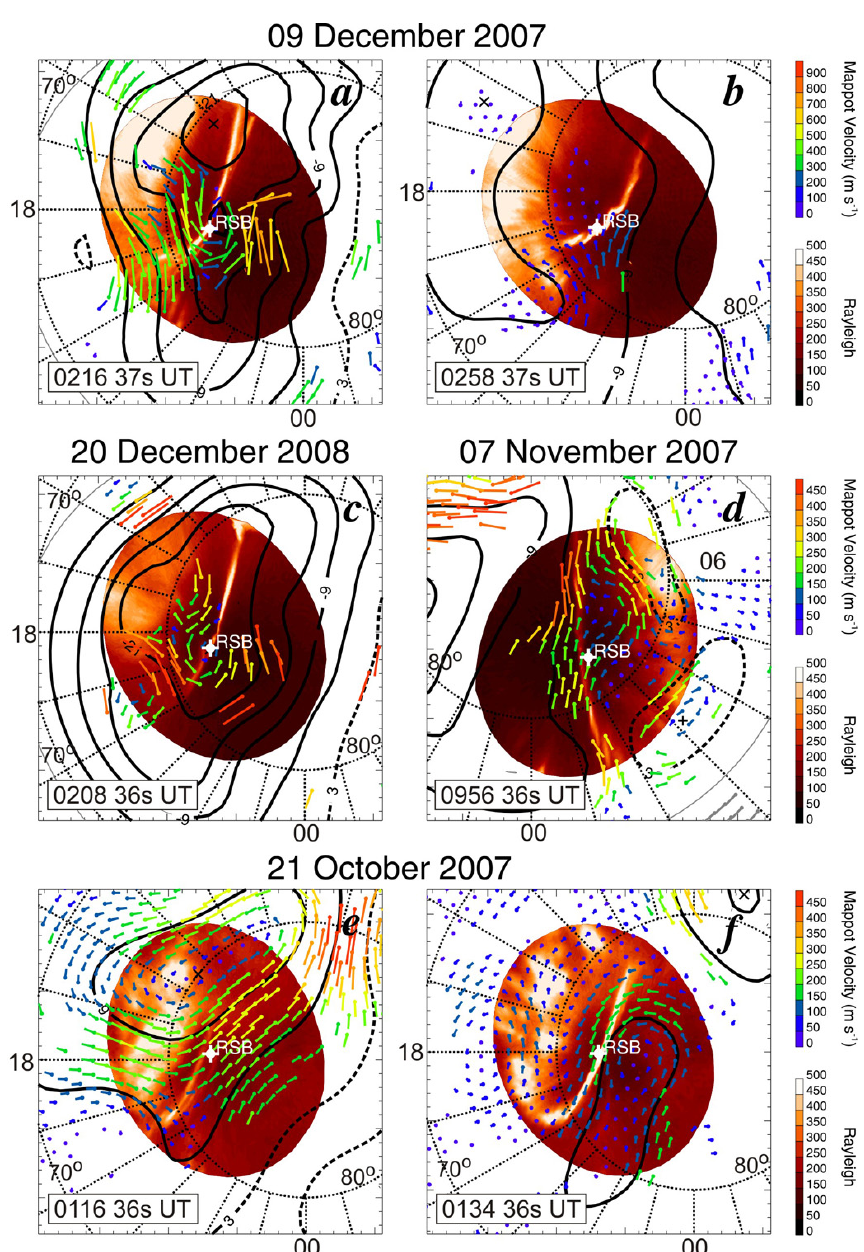
Fig. 11. SuperDARN convection maps with overlaid auroral images for selected scans on (a) , (b) 9 December 2007, (c) 20 December 2010, (d) 7 November 2007 and (e) , (f) 21 October 2007. Notice that for the 9 December 2007 event, panels (a) and (b) , the scale on the velocity color bar is 2 times larger than for other